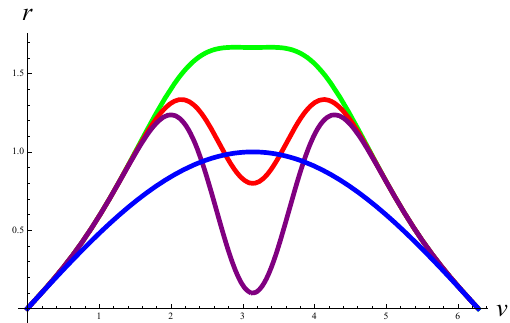
Figure 2 . The function r ( v ) is shown for various parameters of (cid:15) with l = 1 and n = 6. The dashed (green), dotted (red), and dot-dashed (purple) curves correspond to (cid:15) = 5 = 3, 4 = 5, and 1 = 10, respectively. The solid (blue) curve is for r = sin( v= 2), corresponding to the static Einstein universe. As (cid:15) becomes small, a wormhole throat appears at v = (cid:25) and the radius of the throat becomes